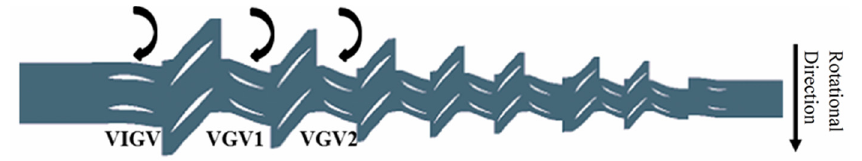
Figure 2. Turning direction of VGVs.